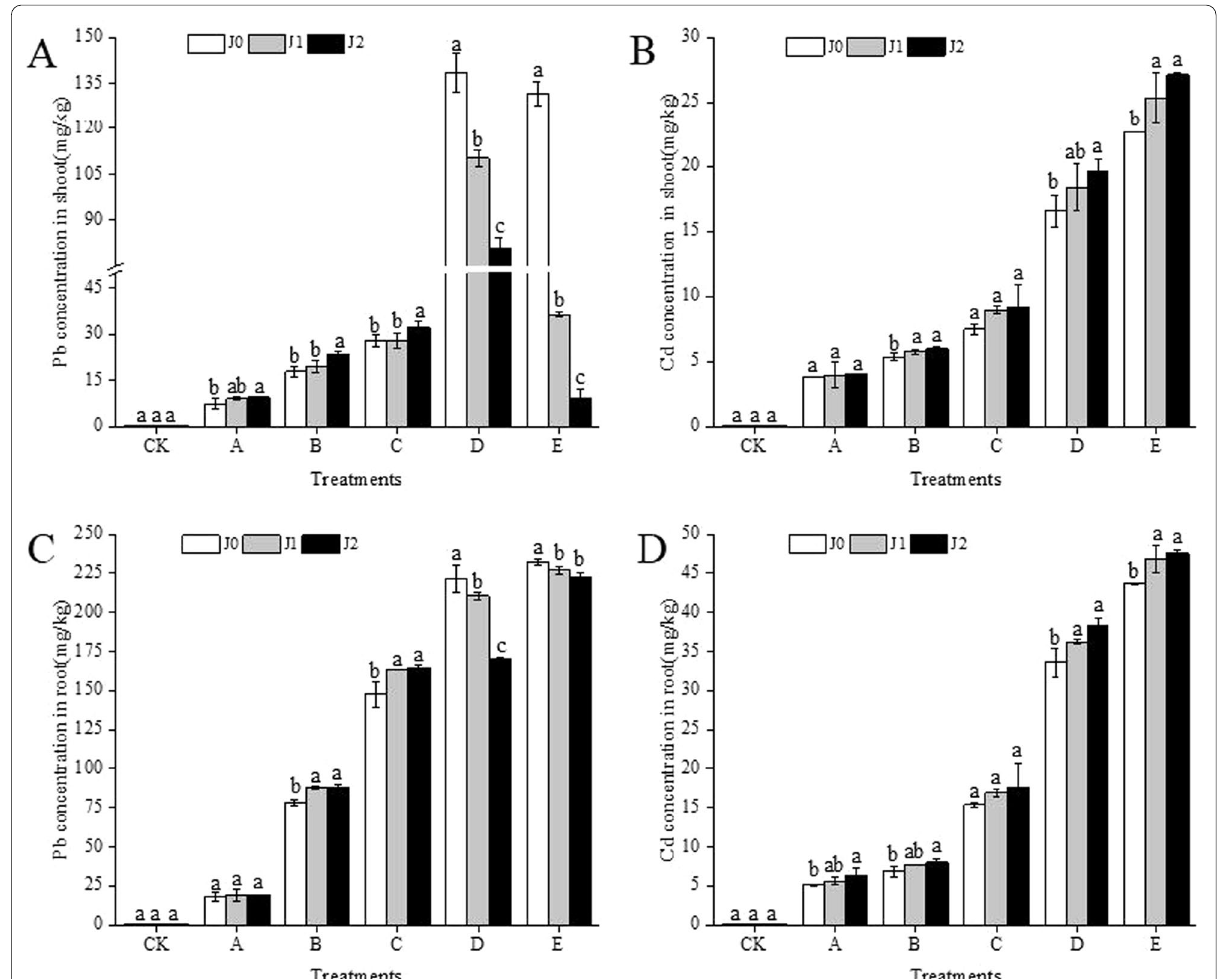
Fig. 4 Uptake of Pb and Cd by Sedum alfredii Hance under different Pb and Cd concentration treatments . This figure represents the changes of Pb and Cd contents in aboveground and underground parts of Sedum alfredii Hance at different Pb and Cd concentration treatments. A shows the Pb content in the shoot of plants under different treatments, C corresponds to underground; B shows the Cd content in the shoot of plants under different treatments, D corresponds to underground. Different letters indicate a significant difference at P <